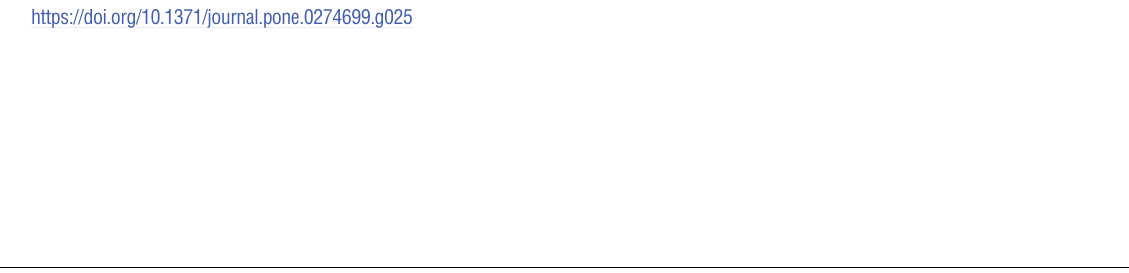
PLOS ONE | https://doi.org/10.1371/journal.pone.0274699 October 19,